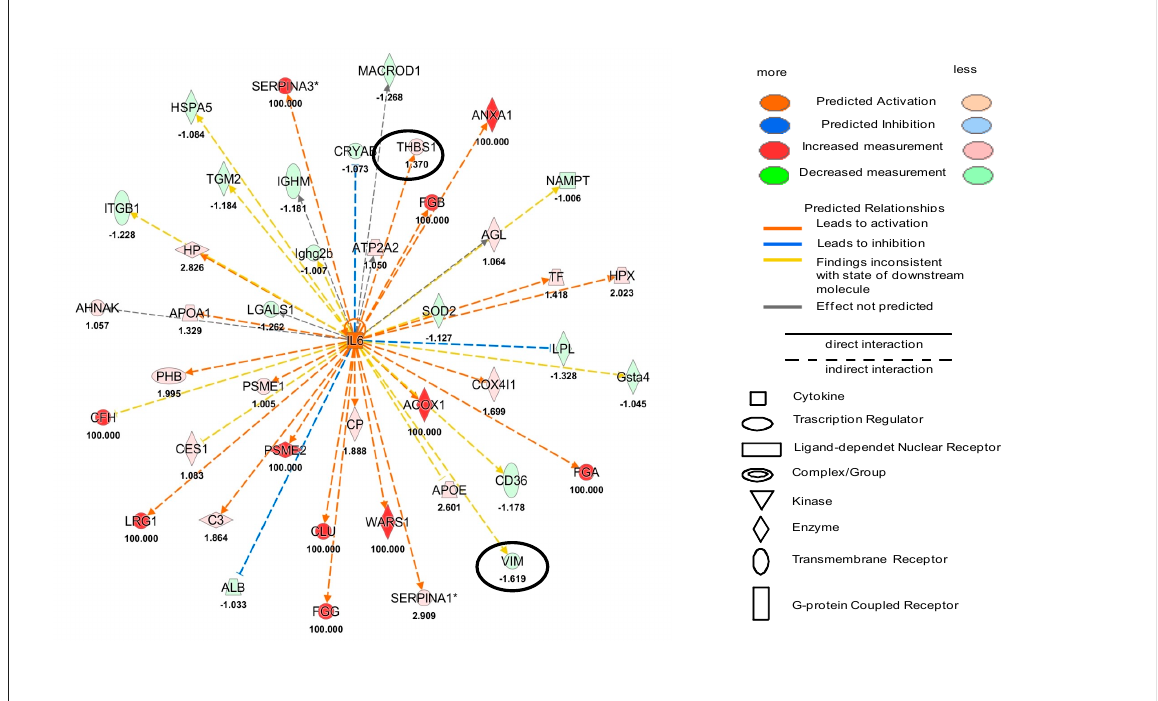
Figure 3. Male proteomic analysis. Upstream network effects of a quantified protein in the Ingenuity Pathway Analysis (IPA) revealed the activation of IL6 in male mice cardiac tissue treated with ponatinib compared to control ones. Red and green shapes represent increased or decreased measurements of identified proteins, respectively. Color intensity is directly proportional to the fold change value of each protein reported in the figure. Circles show target molecules of Cx43. Color key and symbols are reported in the legend.